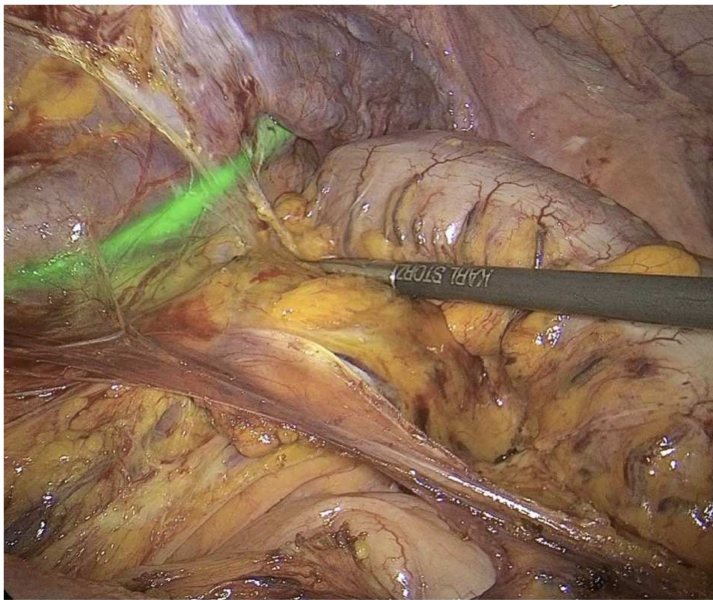
Figure 2. The intraoperative administration of indocyanine green (ICG) in the distal ureter can provide valuable insight during surgical dissection, preventing its unintentional damage